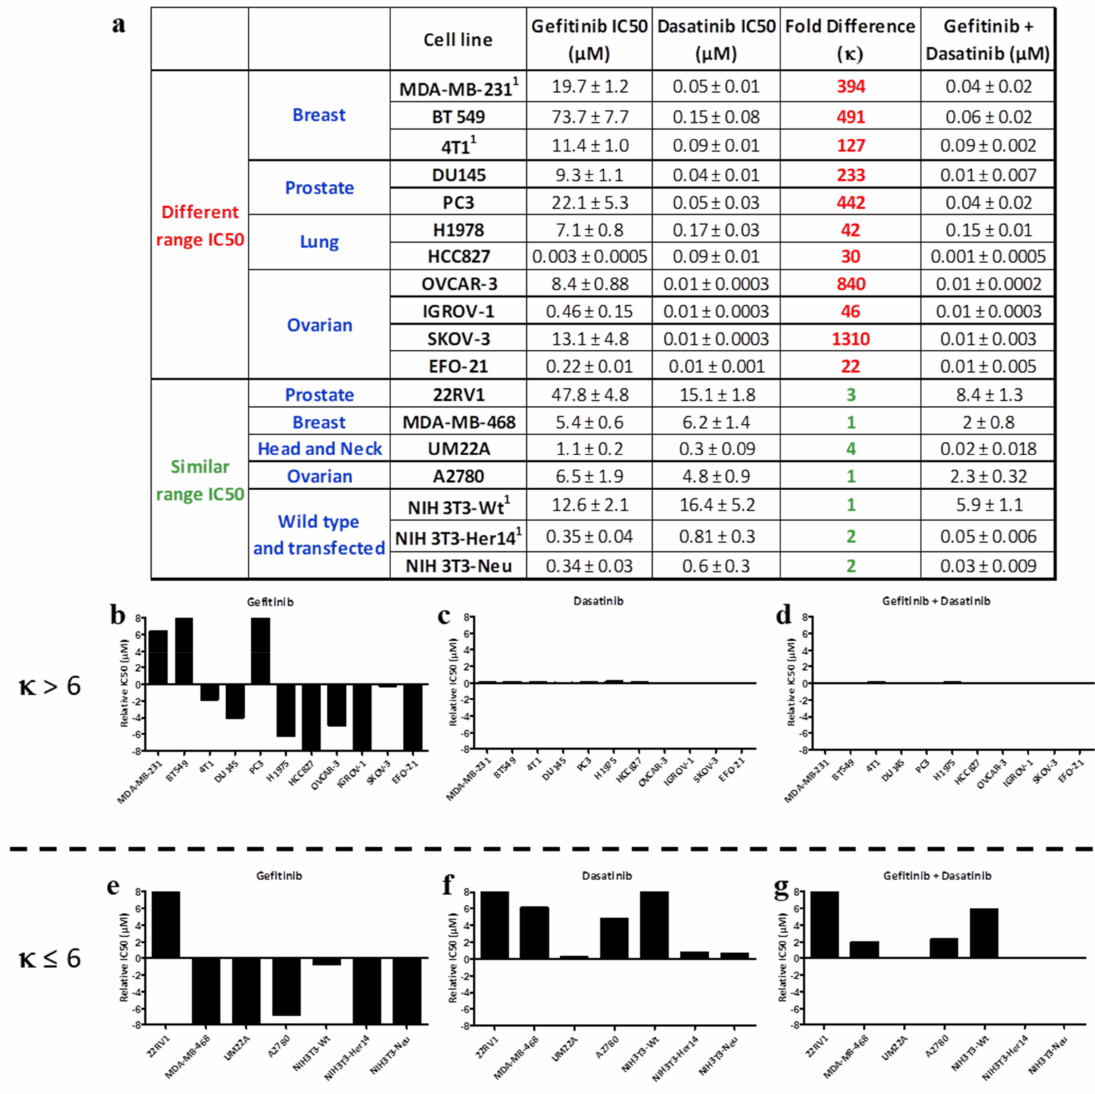
Figure 1. ( a ) IC50 values of tumor cell growth inhibition on a panel of human cancer cell lines using gefitinib (EGFR kinase inhibitor), dasatinib (c-Src kinase inhibitor), and their equimolar combination. The fold difference between the IC50 values of the two individual drugs is denoted by κ . ( b – g ) Relative IC50 values (IC50 of individual drug minus the average IC50 of the drug on the entire panel of cell lines) of gefitinib, dasatinib, and their equimolar combination for ( b – d ) κ > 6 and ( e – g ) κ ≤ 6. 1 Rao S. et al., 2015